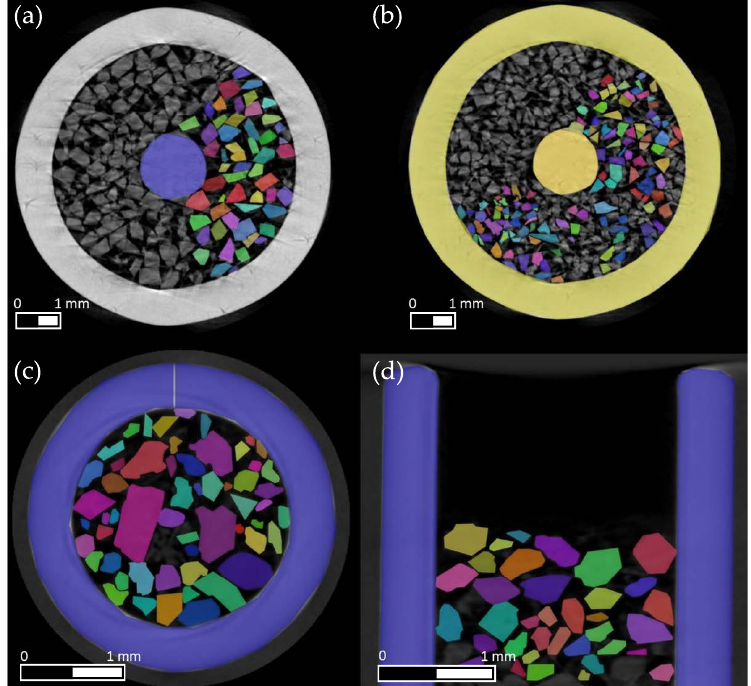
Figure 2. Sample of the labeled dataset of the µCT measurements of sucrose bulk samples. ( a ) shows particles with a sieve size of 250–400µm. ( b ) shows particles with a sieve size of 180–250µm. At the bottom, significantly larger particles from a non-sieved sample can be seen in radial ( c ) and axial directions ( d ) (without the needle in the sampler). In each of the images, a portion of the particles was manually labeled for training